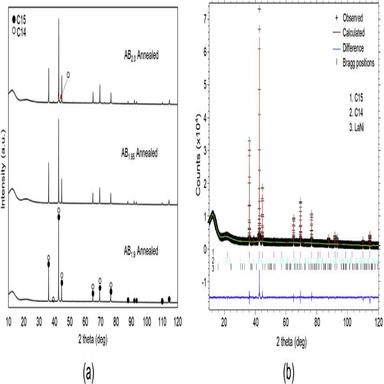
XRD patterns (Cu-Ka1) for the studied alloys (a) and typical Rietveld refinement for the AB1.9 annealed alloy shown as an example (b). Two Laves phase type intermetallics (C15 and C14) are present. Content of C15 phase exceeds 95 wt % for all studied alloys, see